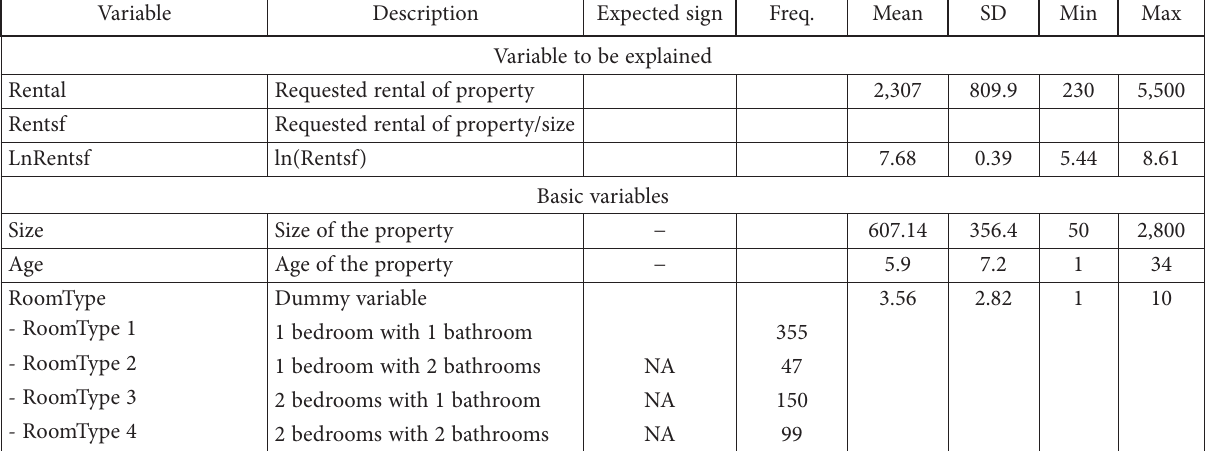
Table 2. Summary statistics of housing variables of Panel